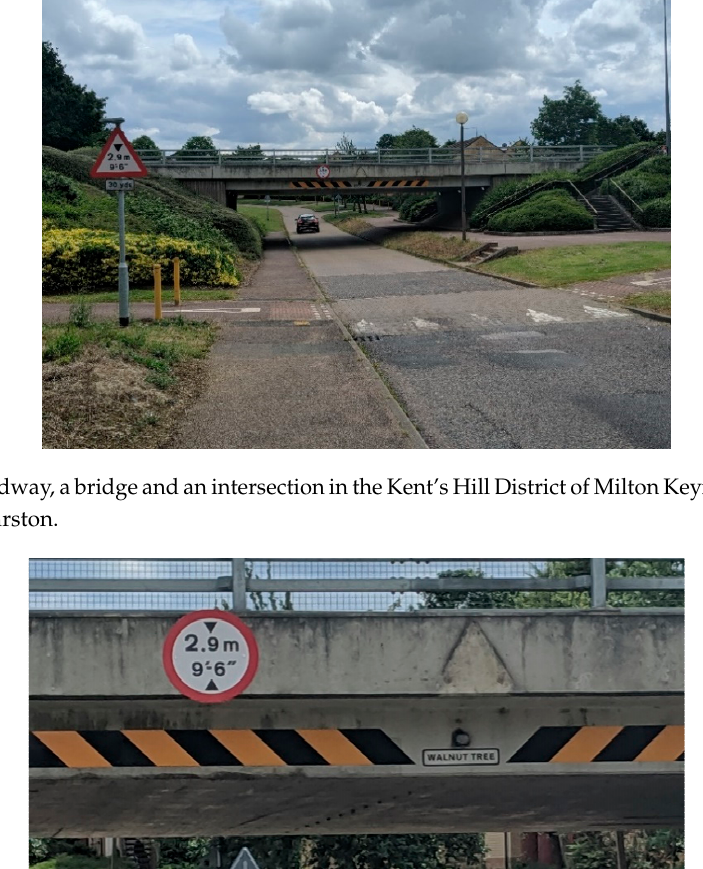
Figure 6. The name of the Bridge. Walnut Tree is the next district that is accessible on the opposite side of the bridge and this inform pedestrians, residents and motorists where they are travelling towards. Permission granted by Marston.